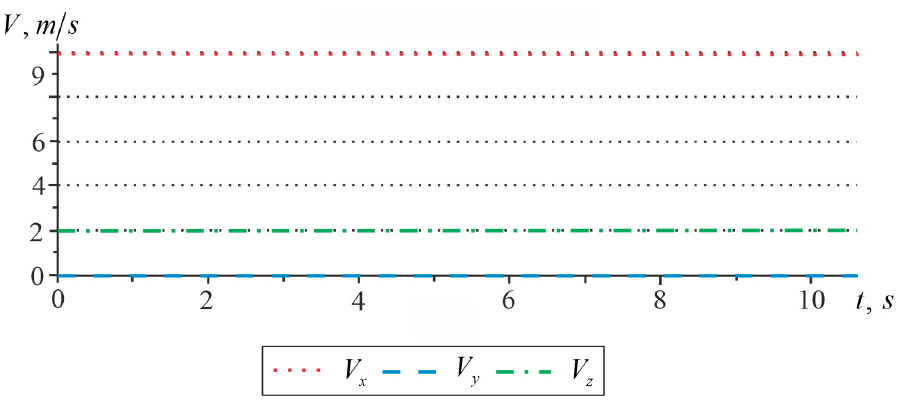
Figure 6. Estimates of the velocity vector components (first simulation).